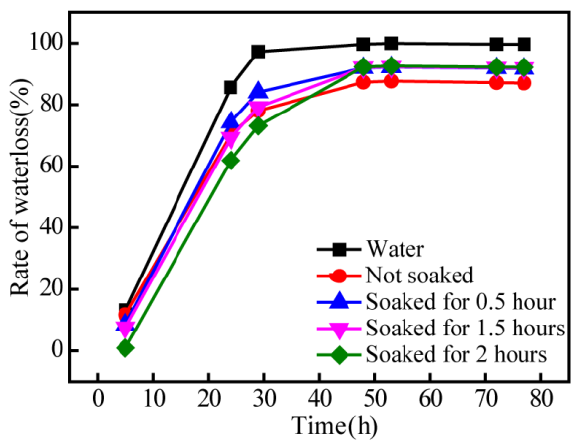
Figure 9. Variation curves of samples ’ water loss rate over time.